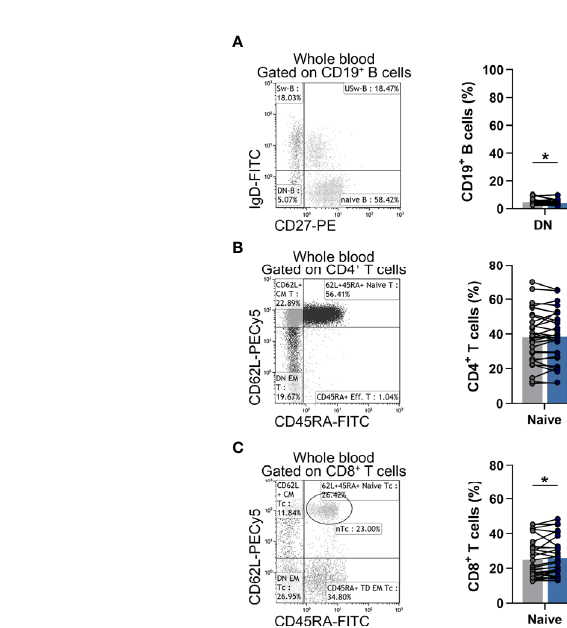
FIGURE 3 | Changes in the division of naïve and memory lymphocyte subsets in elderly women after the workout program. Whole blood of 29 elderly individuals were stained with labeled monoclonal antibodies as described previously. B cell subsets were quanti fi ed as their proportions in CD19 + lymphocytes, Th subpopulations were assessed as their ratio in the CD4 + cells, while Tc cell subsets were quanti fi ed as their percentages in CD8 + cells. (A) Representative dot plot indicates the distribution of naïve, double negative (DN), switched and un-switched memory B cells. The bar chart shows the percentages of B cell subsets. (B) Representative dot plot demonstrates the distribution of naïve, effector memory RA + (EMRA), central memory (CM) and effector memory (EM) Th cells. The bar chart indicates the frequencies of Th cell subpopulations. (C) Representative dot plot demonstrates the distribution of naïve, EMRA, CM and EM Tc cells. The bar chart indicates the frequencies of Tc cell subpopulations. Paired T test or Wilcoxon test was used for statistical analysis. Each data point represents an individual subject, while bars show the mean values. Statistically signi fi cant differences are indicated by *p < 0.05; **p < 0.01.